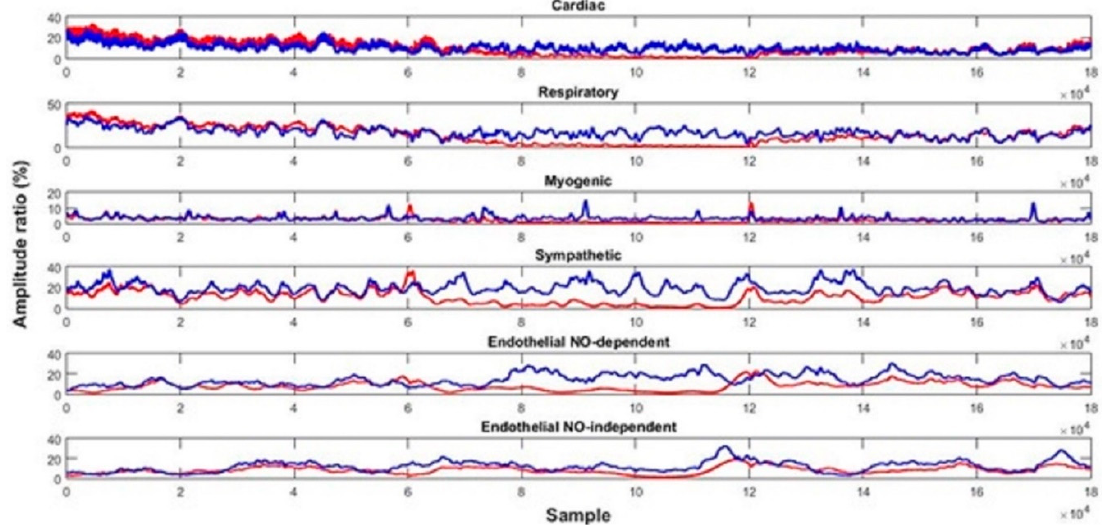
Figure 4. Time evolution of the PPG signal components’ amplitude ratio for the control (blue) and test (red) feet throughout the protocol (baseline: signal samples 0–60,000; challenge: signal samples 60,000–120,000; recovery: signal samples 120,000–180,000) for a representative subject (20 y.o.).